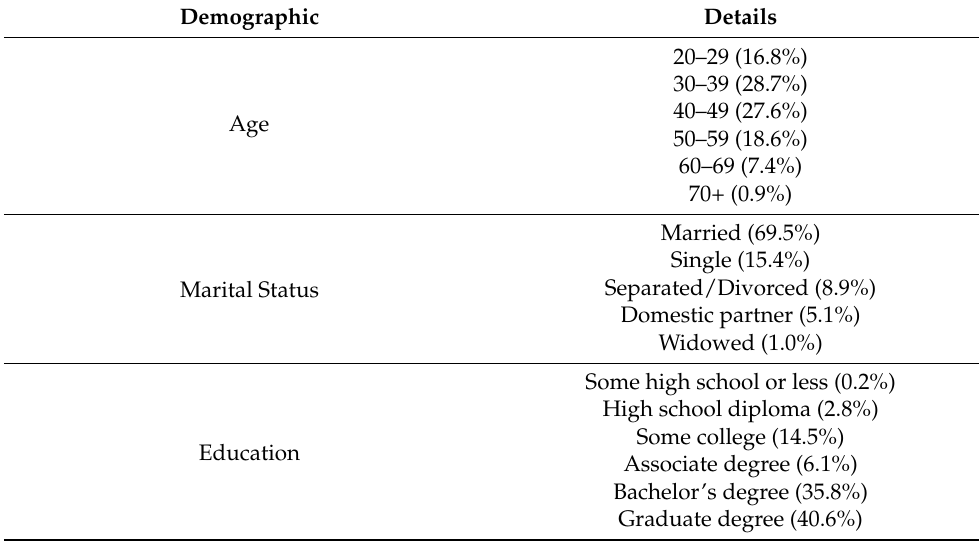
Table 1. Qualitative Participant